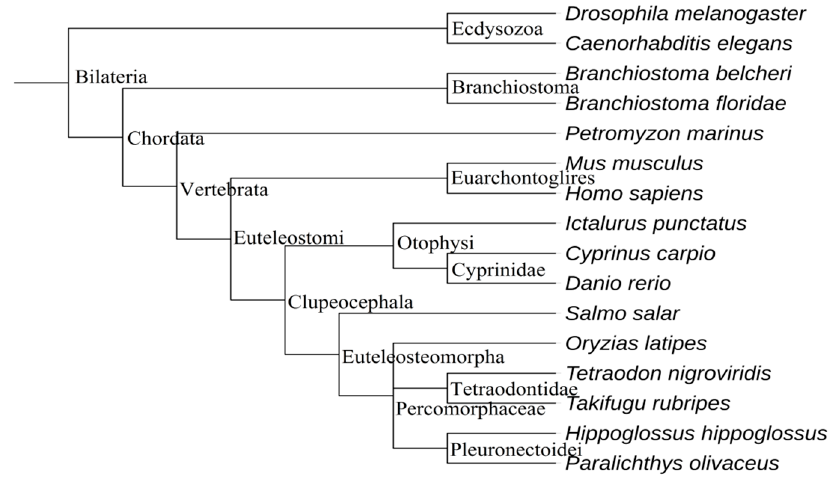
Figure 2. The genetic relationship for all the species of which let-7 miRNAs sequences were collected in the present study.